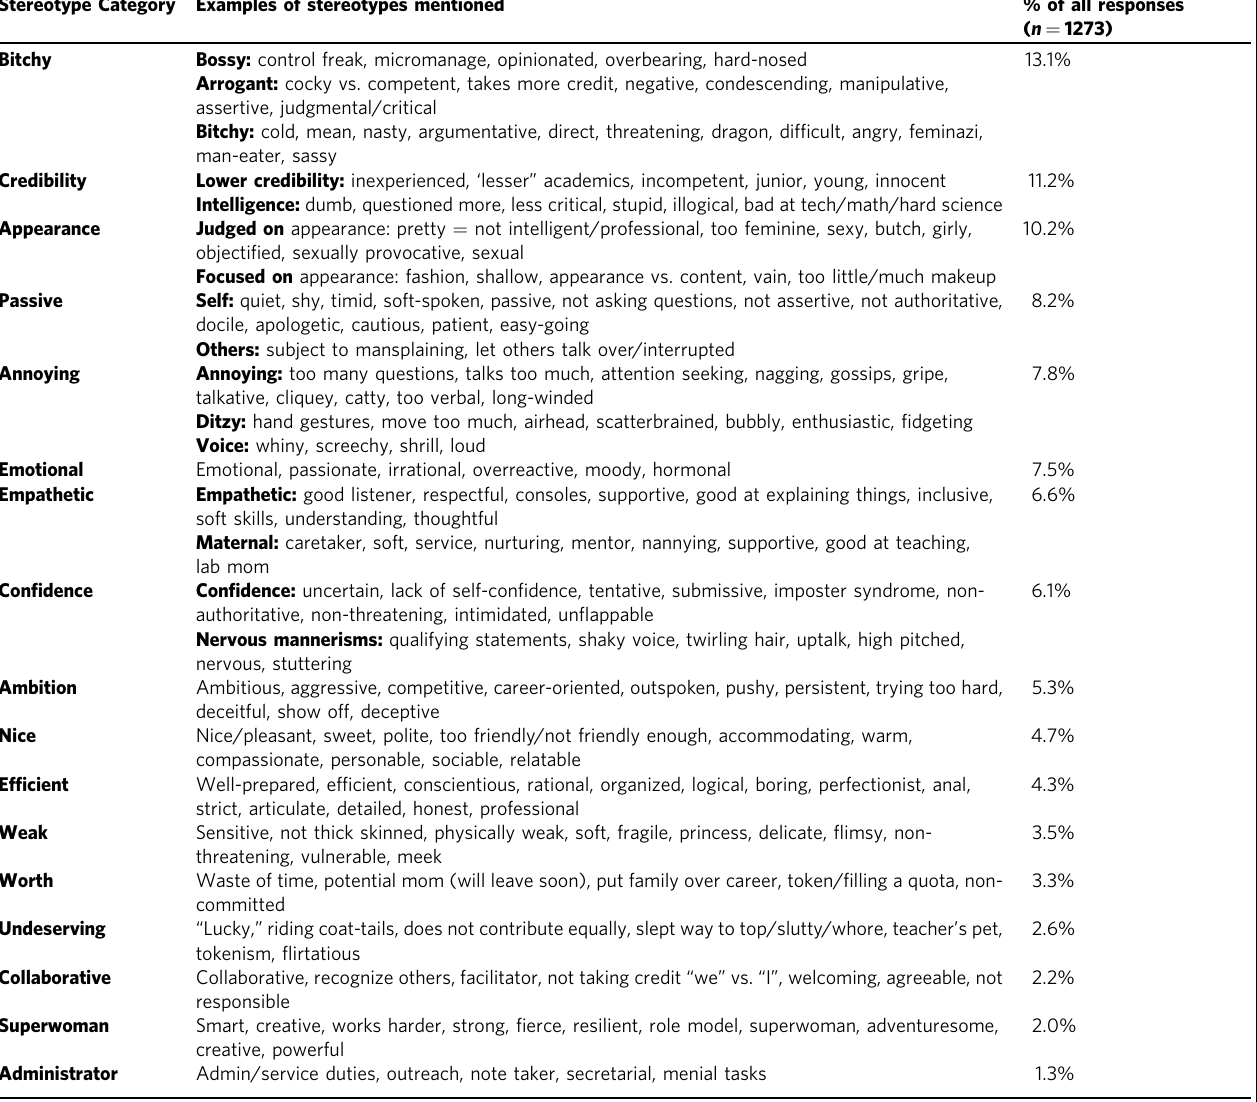
Table 2 Stereotype categories, with indicative samples, identi fi ed through the coding of focus group responses. Stereotype Category Examples of stereotypes mentioned